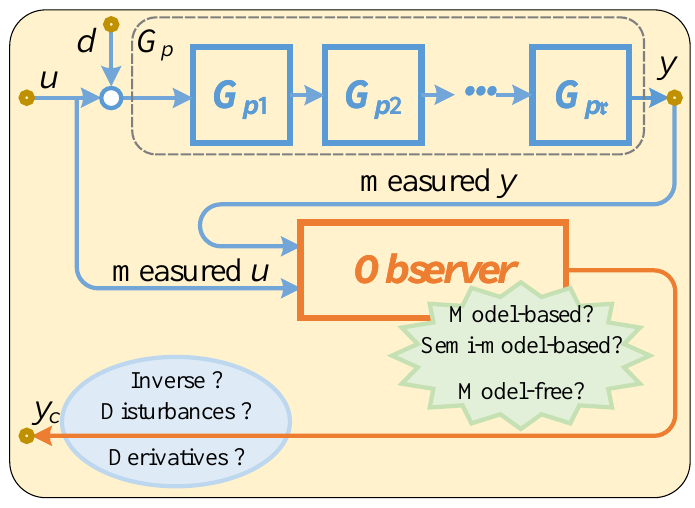
Figure 1. The observer